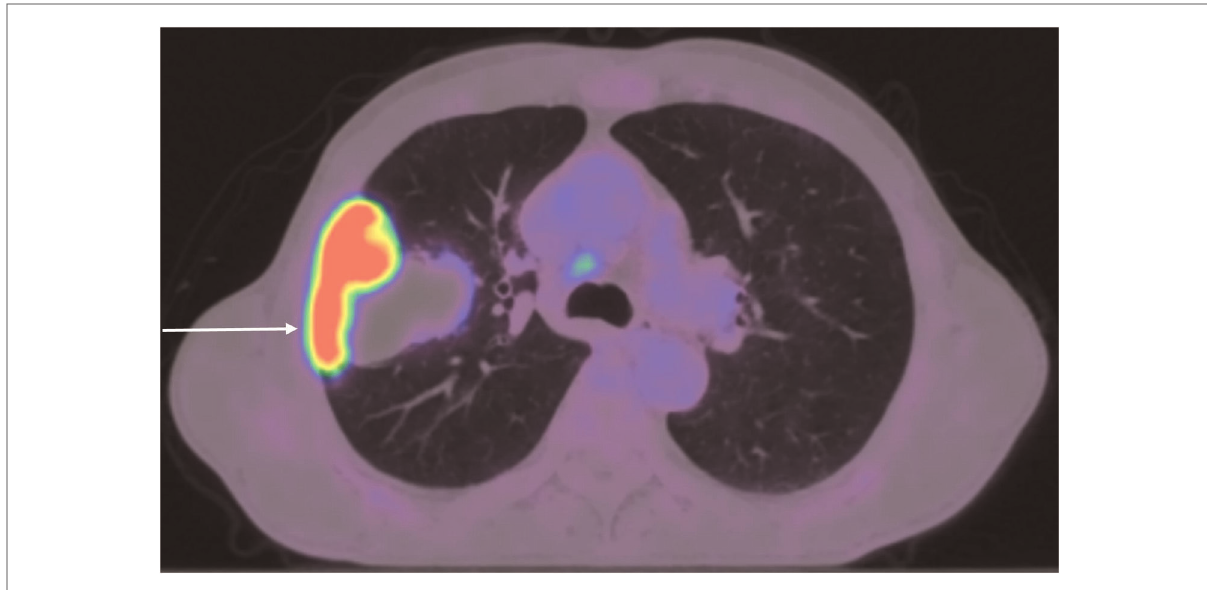
FIGURE 1 18F- fl uorodeoxyglucose positron emission tomography integrated with CT showing heterogeneous radiotracer uptake within a pulmonary mass originating in the right upper lobe and in fi ltrating the chest wall, as well as low-grade metabolic activity in right lower paratracheal lymph nodes.